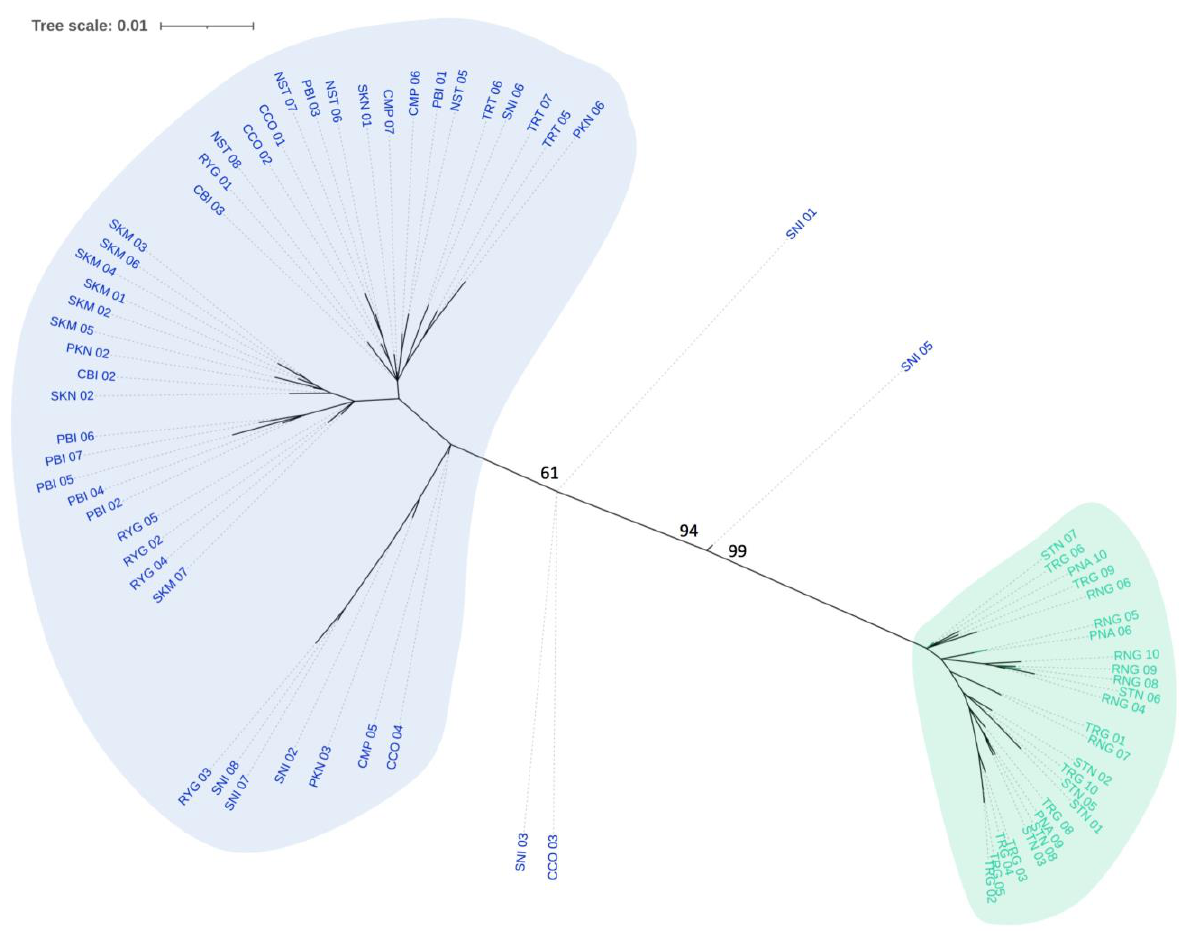
Figure 3. Unrooted phylogenetic tree inferred by maximum likelihood analysis of 73 B. gymnorhiza accessions using 1519 SNP markers. Blue and green texts in the ML tree indicate two different sampling sites in the Gulf of Thailand and the Andaman Sea sides, respectively.